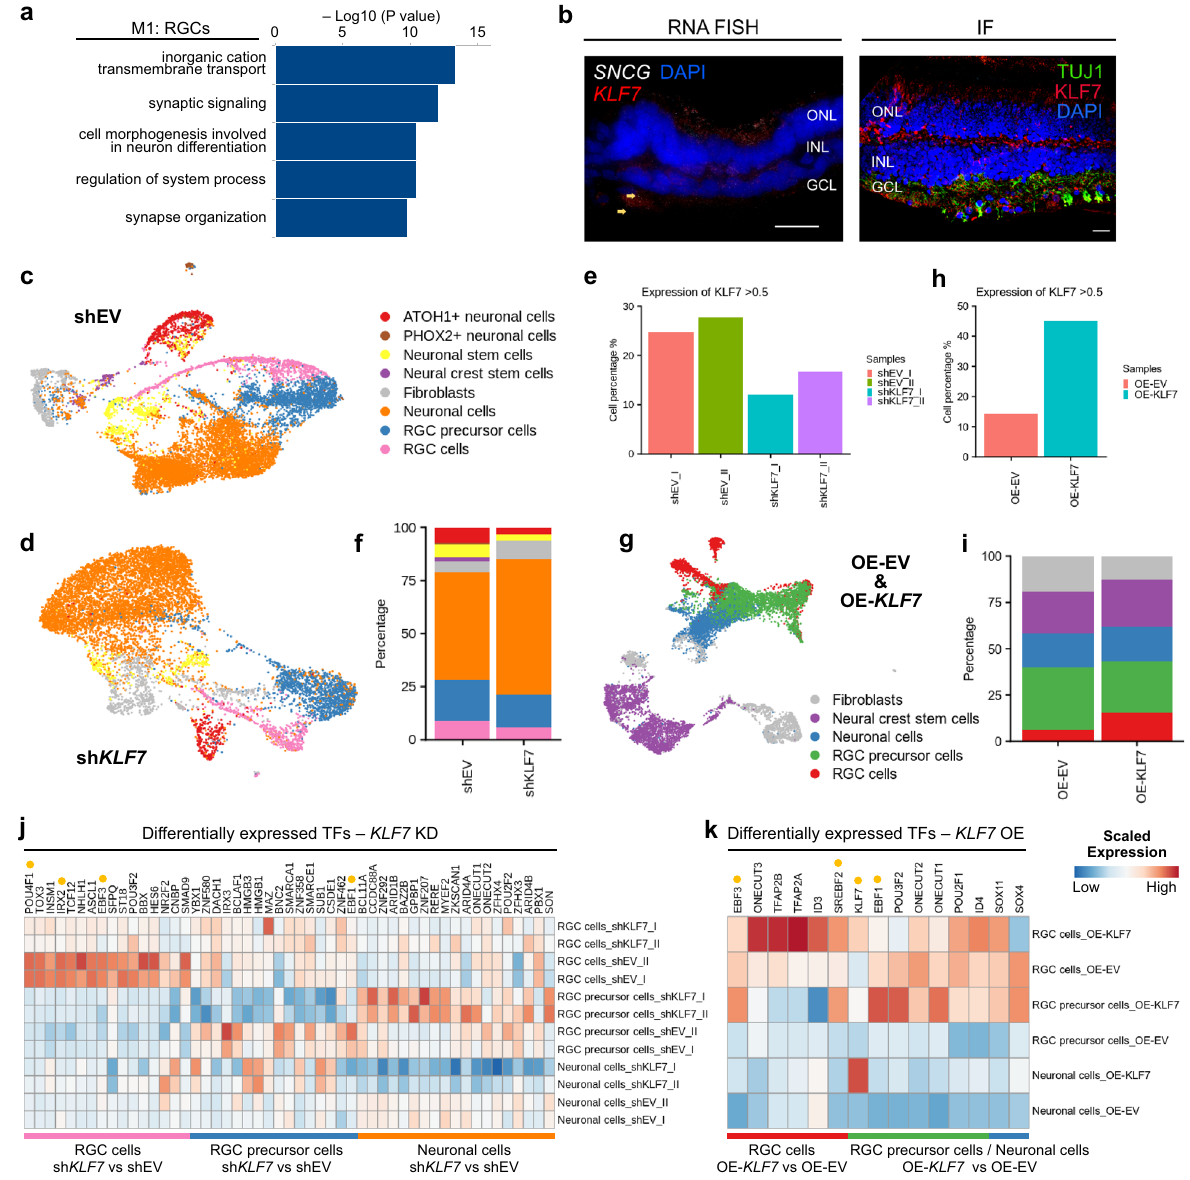
Fig. 7 KLF7 acts as a driver for RGC maturation. a GO analysis of TFs and their targets speci fi c to M1 modules. Metascape calculated the statistical signi fi cance of each GO term enrichment ( p -value) based on the accumulative hypergeometric distribution. b Representative RNA FISH images of the RGC- speci fi c TFs KLF7 . n = 2 technical replicates. Immuno fl uorescence of the KLF7 with TUJ1 was also shown in the non-human primate retina. n = 2